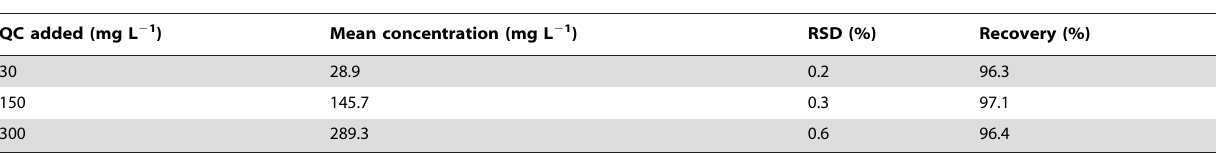
Table 1. Precision and accuracy data for the Cd 2 + analyses.